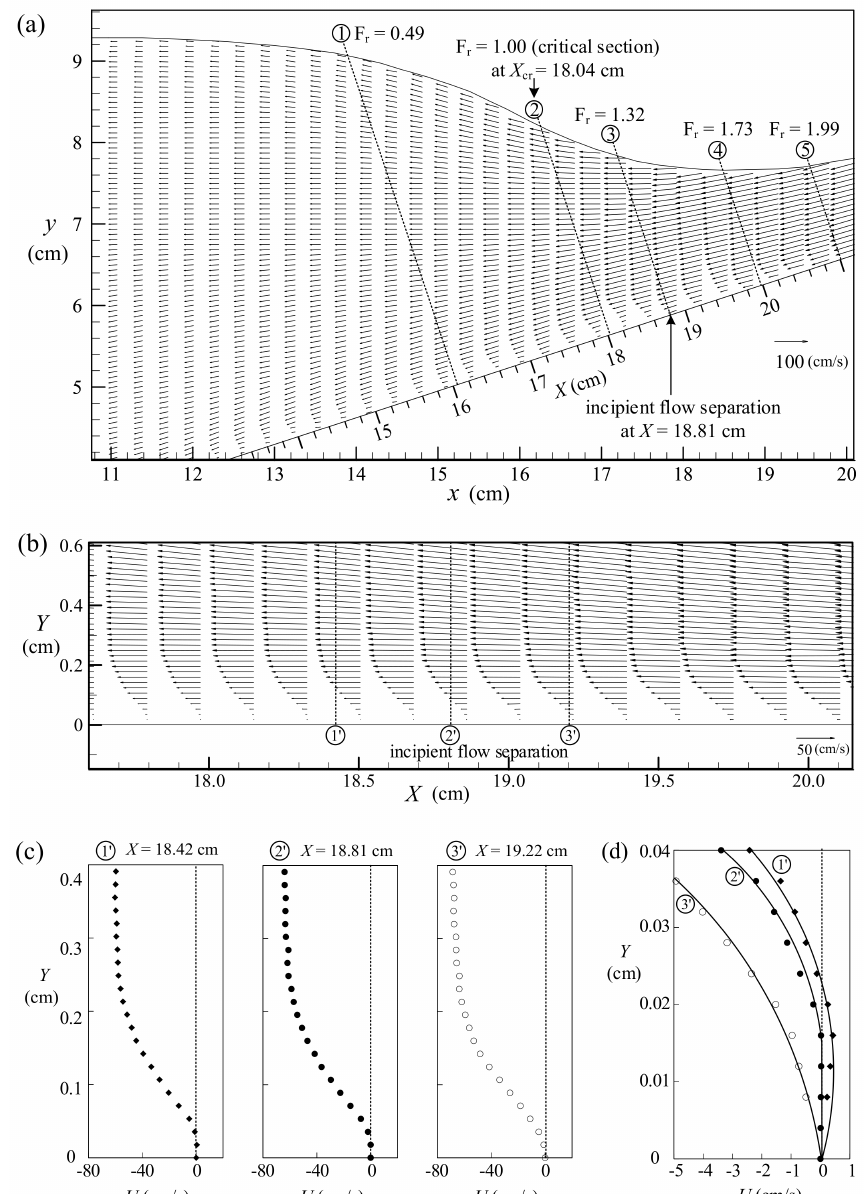
Figure 11. ( a ) Spatial variation of velocity field at t = 0.921 s; ( b ) near-bottom velocity field obtained at t = 0.921 s; ( c ) three velocity profiles selected from (a), depicting incipiency of flow separation in boundary layer at X = 18.81 cm, as shown in sub-figure 2’; and ( d ) detailed comparison of three velocity profiles very close to the beach surface (Case